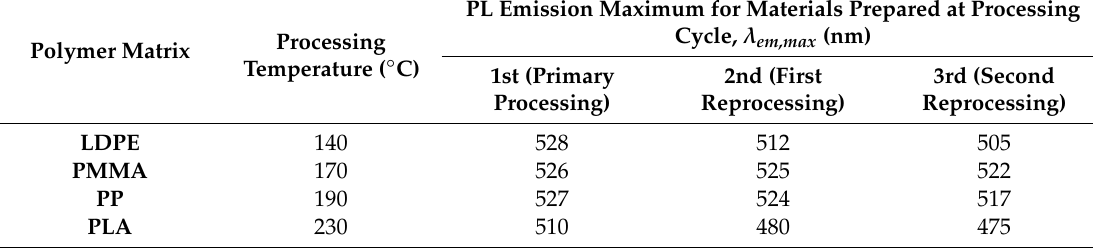
Figure 3. Normalised PL emission spectra of samples of PTMSDPA-labelled polymer compounds in the third processing cycle (i.e., second reprocessing). Each PL emission spectrum was recorded using excitation wavelength set to the maximum of the excitation spectrum of the respective compound individually. Table 1. Photoluminescence emission maxima observed for all marked polymer samples ordered according to the processing temperature and to the number of the processing cycle.